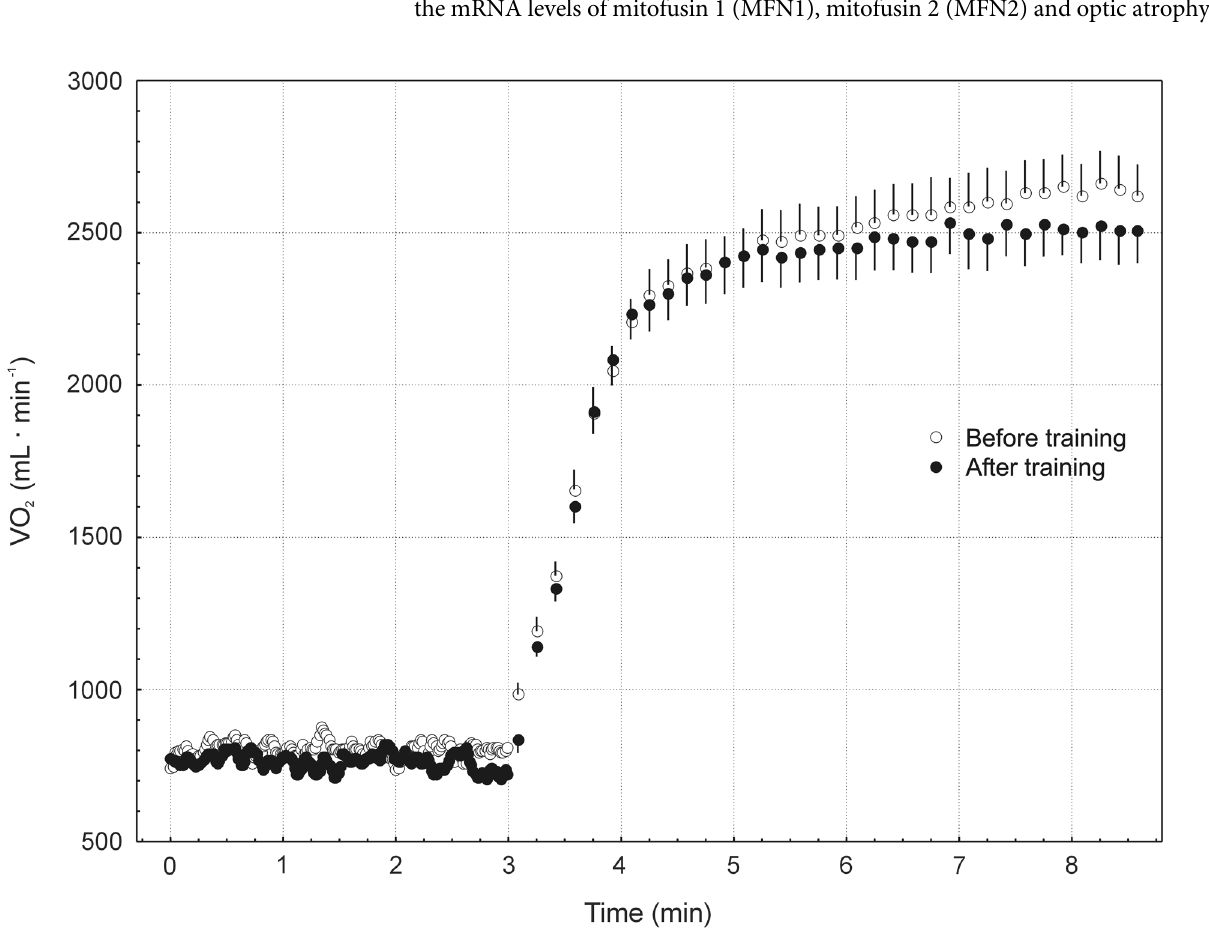
Fig 4. Mean ( ± SD) values of pulmonary oxygen uptake (V ’ O 2 ) for 12 subjects during baseline and during heavy-intensity transition. Note the training-induced attenuation of the slow component of the V ’ O 2 on-kinetics during high-intensity